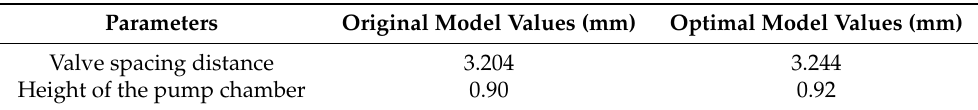
Table 6. Optimal model parameters.